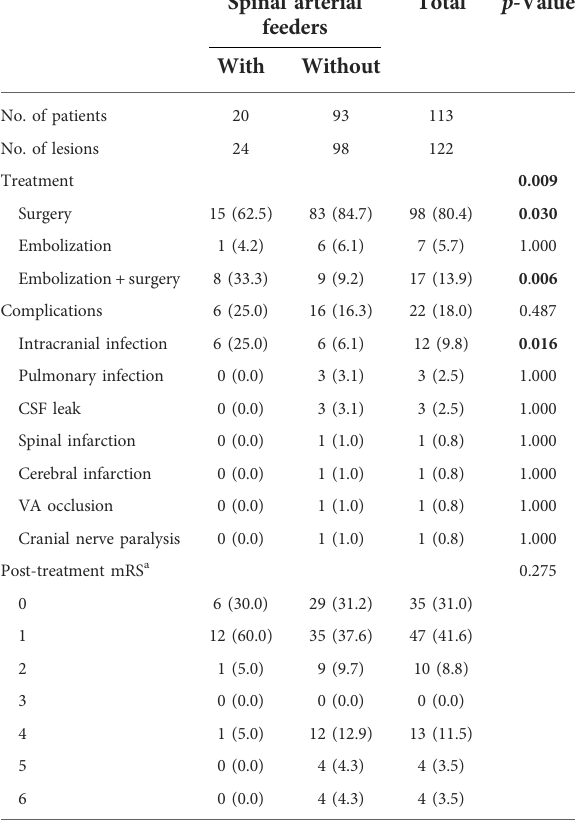
CSF, cerebrospinal fl uid. Bold text indicates statistical signi fi cance. a Post-treatment mRS was evaluated according to the last